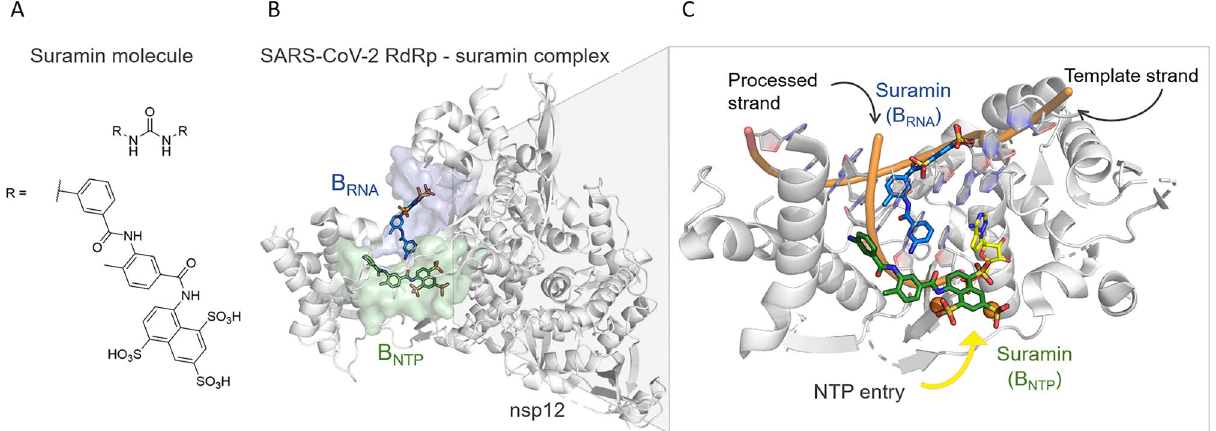
Figure 3. ( A ) 2D structure of suramin. ( B ) Cryo-EM structure (PDB ID 7D4F) 36 of the RdRp-suramin complex. Only the catalytic nonstructural protein 12 (i.e. nsp12) is depicted. On the left, the two binding pockets with suramin molecules bound, i.e. B RNA and B NTP, are depicted as blue and green surfaces, respectively. ( C ) Close view of the two binding sites, the suramin molecules (as blue and green licorice), the superimposed double-strand RNA (as cartoon), and the incoming nucleotide (as yellow